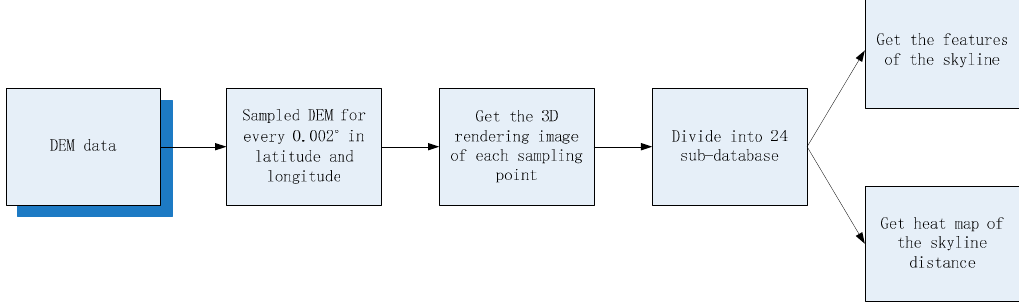
Figure 18. Flowchart for constructing the DEM database.